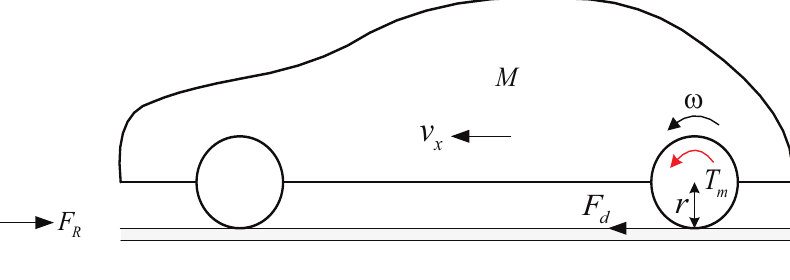
Figure 3. Longitudinal vehicle dynamics